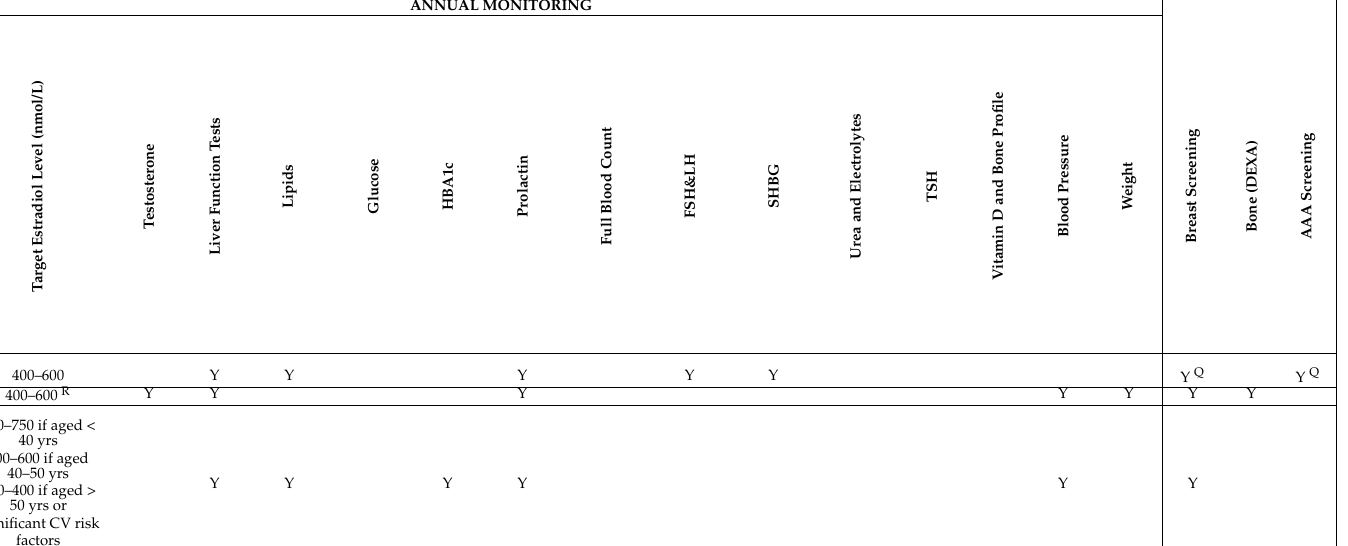
Table 2. Cont. Table 2. Comparison of national, international, and patient specific prescribing and monitoring guidelines for trans women (observed males at birth) with gender dysphoria.